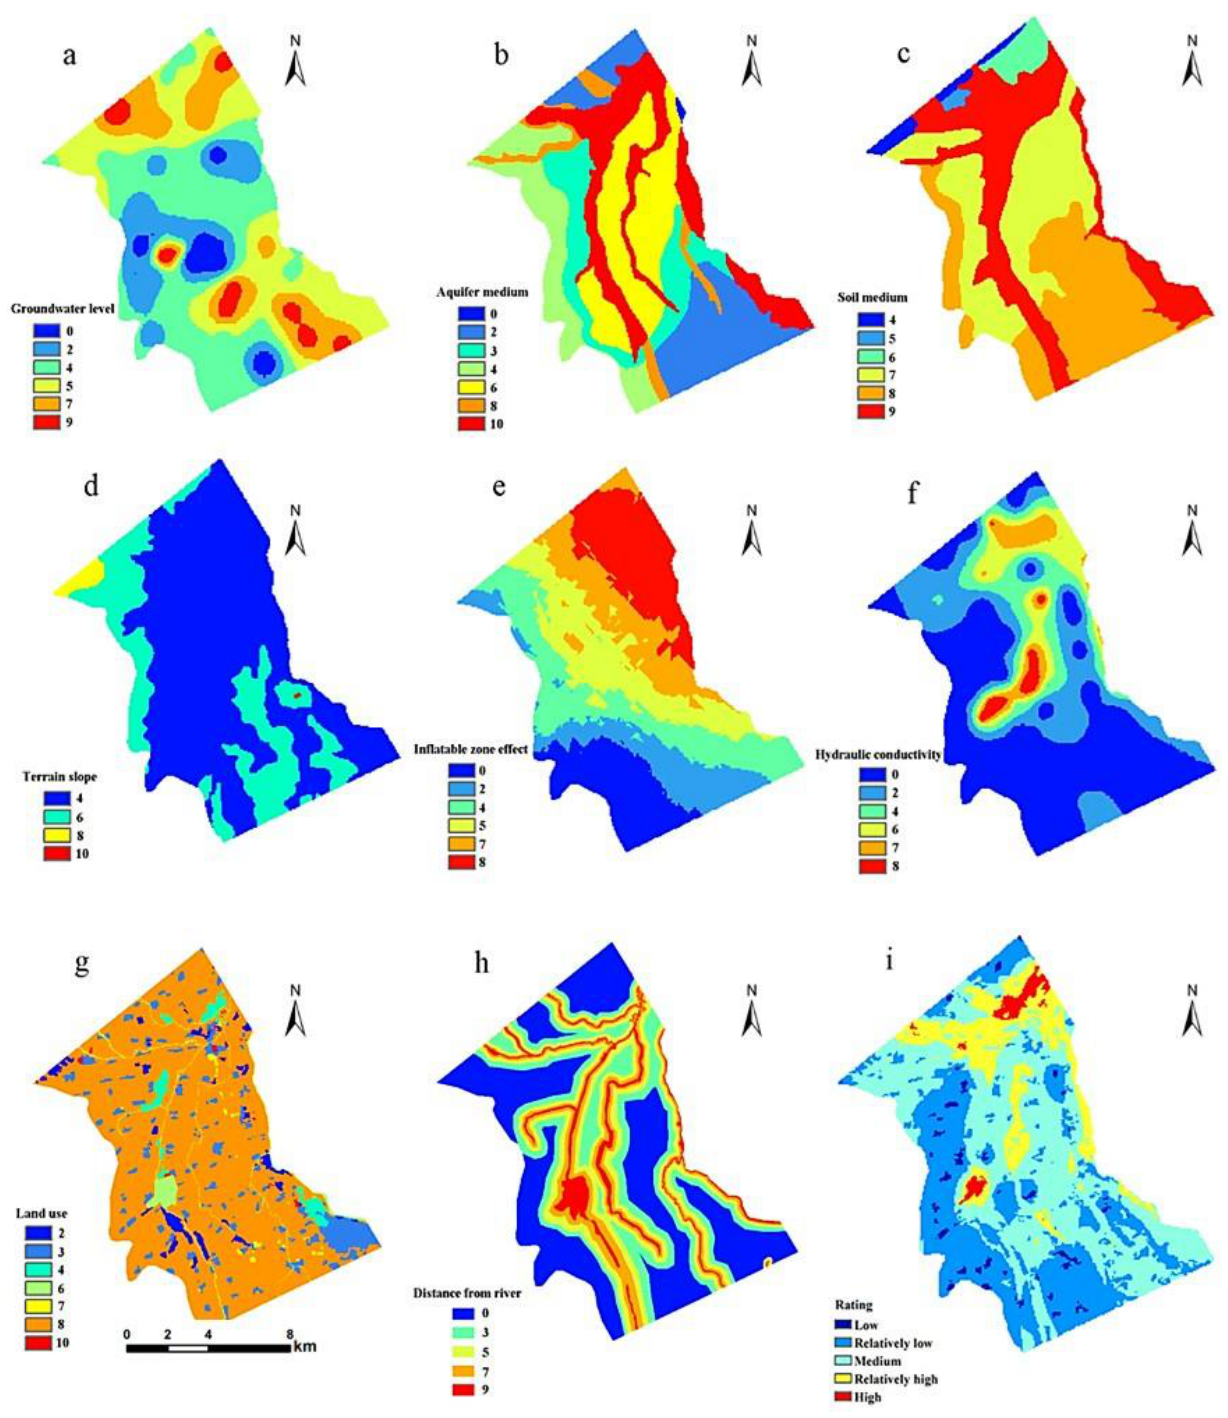
Figure 3. Maps of groundwater vulnerability conditioning factors: ( a ) Groundwater level, ( b ) Aquifer medium, ( c ) Soil medium, ( d ) Terrain slope, ( e ) Inflatable zone effect, ( f ) Hydraulic conductivity, ( g ) Land use, ( h ) Distance to river, and ( i ) Groundwater vulnerability assessment rating